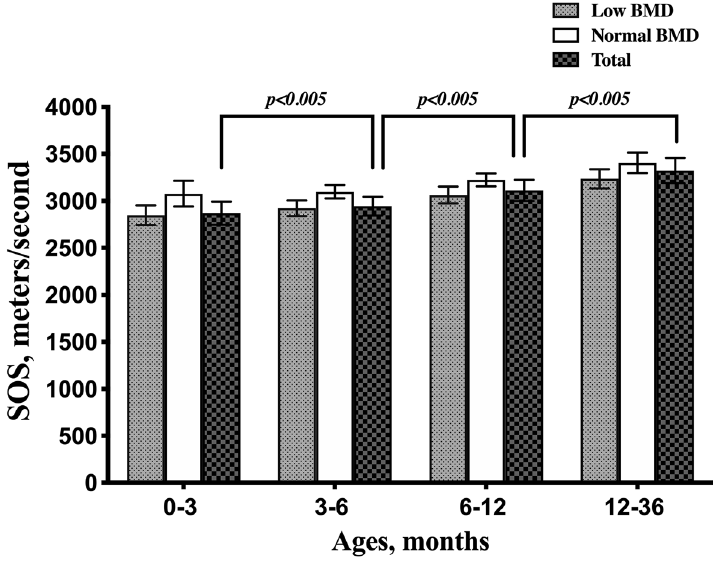
Figure 1. Gradual increase of mean SOS values measured at both normal BMD(white bars) , low BMD (grey bars) and total participants(black bars) with ages progressing. Error bars represent 1 standard deviation from the mean. BMD, bone mineral density; SOS, speed of